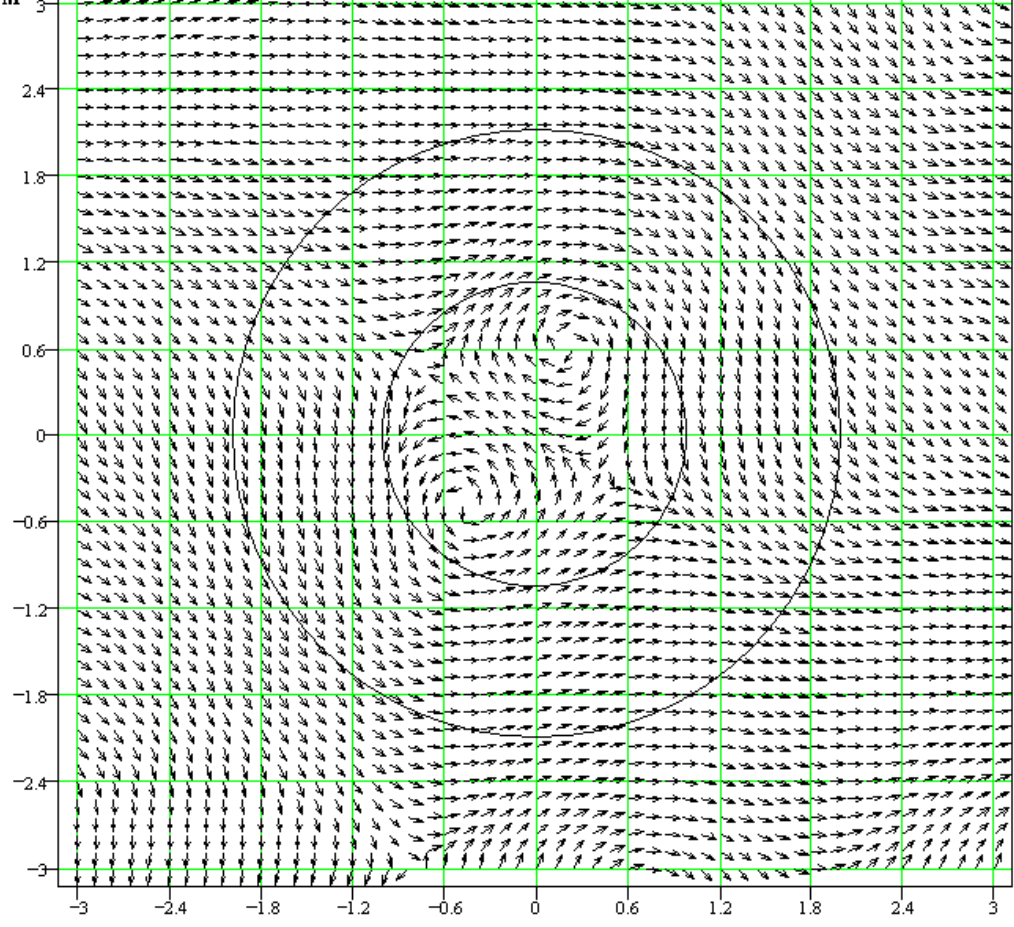
Figure 17. The spatial distribution of the “differential” DOA estimated by an antenna array of 9 elements mounted on a mast; φ incidence = 330 ◦ and f = 62 MHz (at this frequency, due to distortion of measured field structure, there is an "inversion" of DOA estimation—the back lobe of radiation pattern becomes higher than the main lobe); the inner circle corresponds to Real Antenna Array (RAA) ( R RAA = 1 m); radius of the outer circle is 2 m (radius of Virtual Antenna Array (VAA)); in the center of the figure, we can see a turn of the “differential” DOA estimation by 180°.